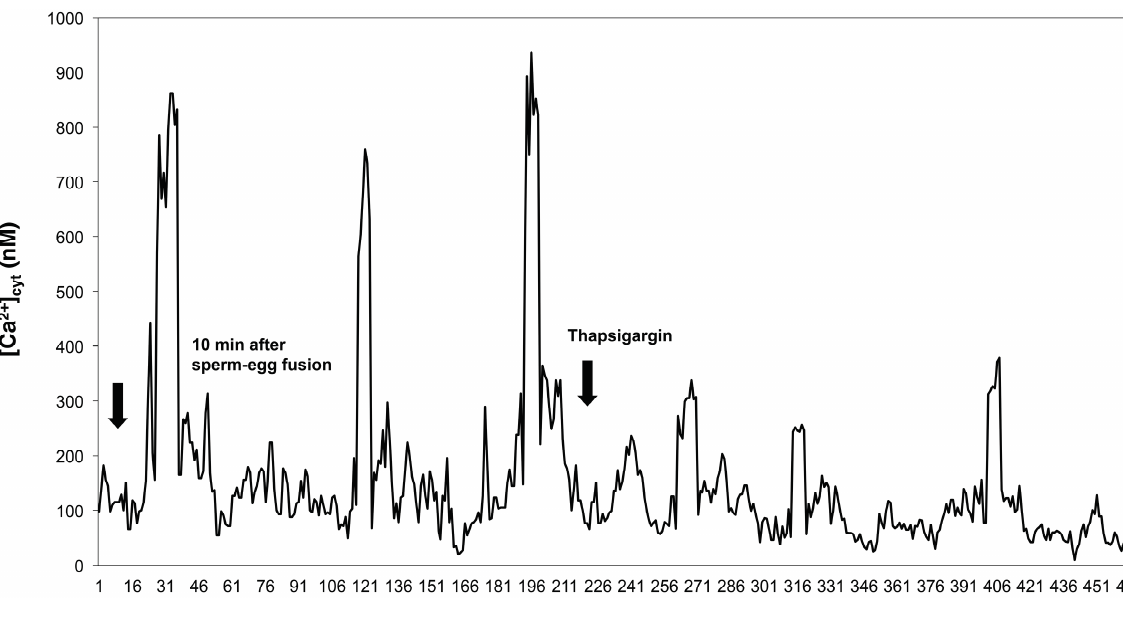
Thapsigargin added following sperm–egg fusion did not produce an increase in [Ca 2+ ] cyt comparable with that triggered by thapsigargin alone; [Ca 2+ ] cyt transients continued for some time, and in all cases analyzed ( n = 25), thapsigargin suppressed the sperm-induced [Ca 2+ ] cyt transients observable during fertilization of the receptive wheat egg (Figure 12). Figure 12. Thapsigargin suppresses [Ca 2+ ] cyt transients following sperm–egg fusion. Egg cells were fertilized in vitro followed by the addition of thapsigargin after the third sperm-induced [Ca 2+ ] cyt transient ensued (the first arrow on the left indicates 10 min